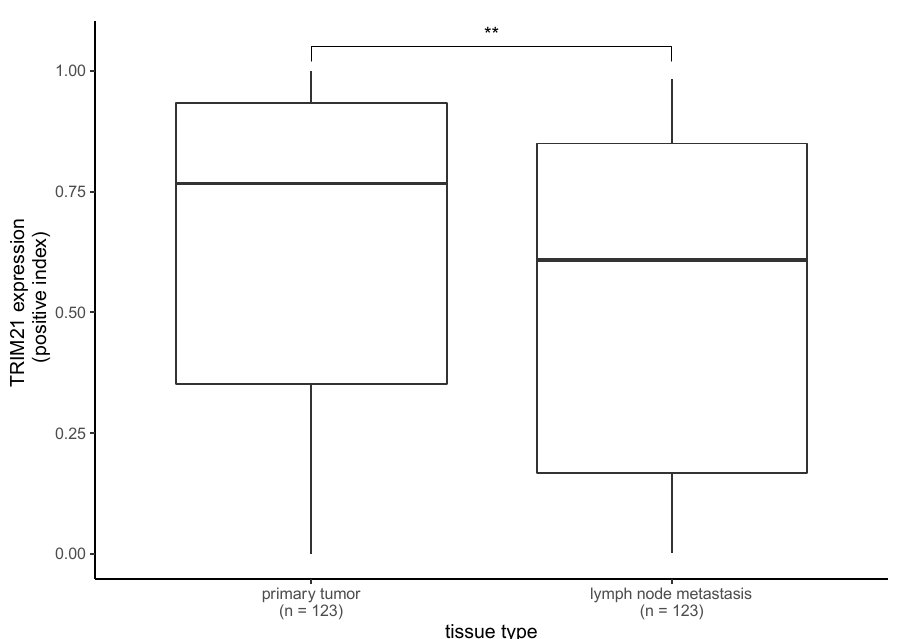
Figure 3. TRIM21 expression in primary tumors matched with the corresponding lymph node metastases from the same patient. TRIM21 expression in primary tumors and lymph node metastases also significantly differed in matched samples (paired sample t ‐ test, p = 0.007). (** p < 0.01).